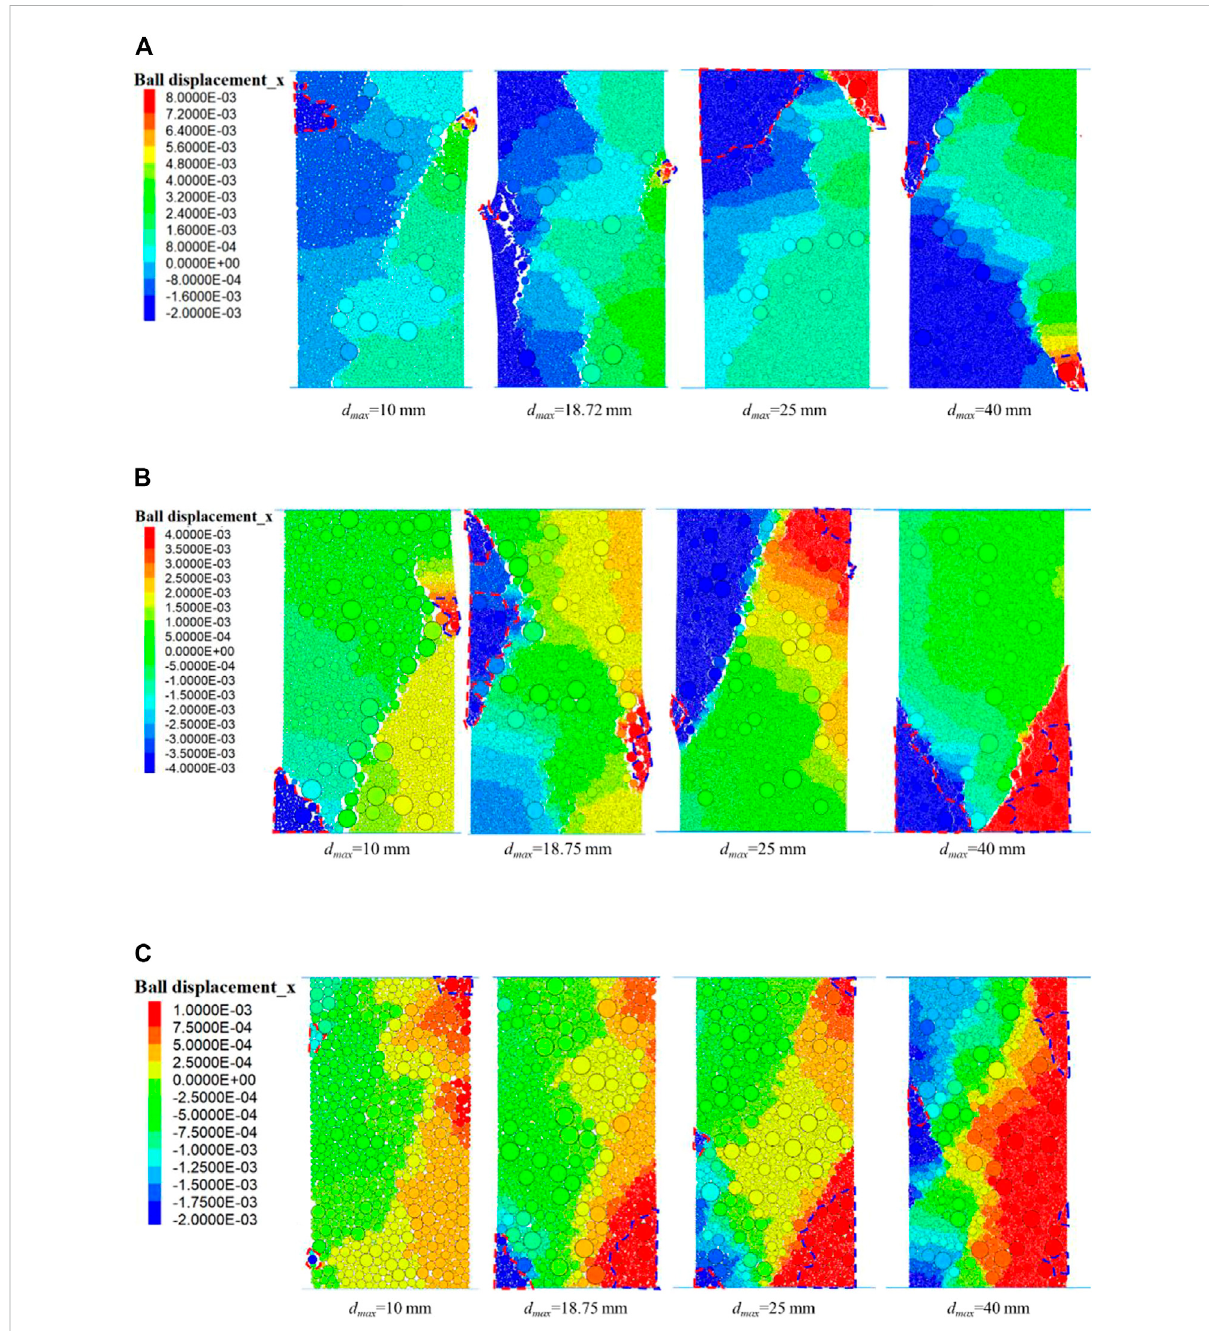
about 85% – 90%. The sample with the lower d max value has a considerably more pronounced detrimental impact of the rock block on the UCS in the low VBP stage (20% and 40%). Because there are more rock particles and soil-rock interfaces with the same VBP due to the smaller rock size, the soil integrity and